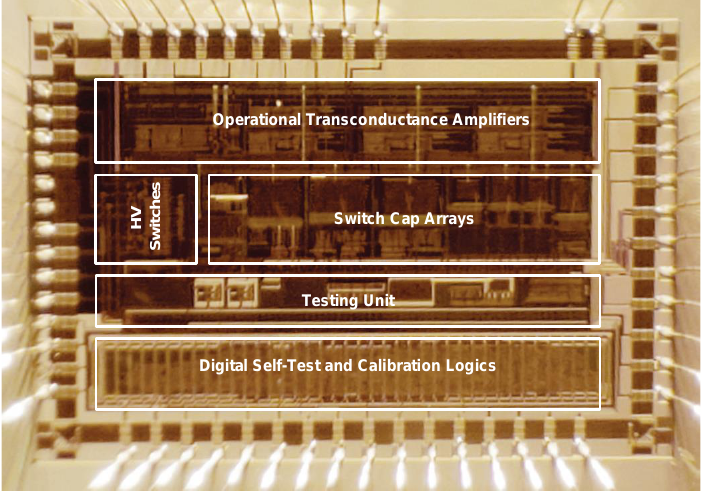
Figure 14. The micro-photograph of the die of the ASIC.